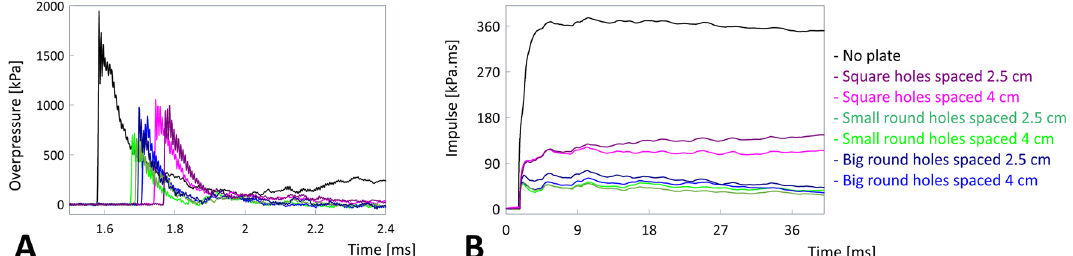
Fig. 12 Reflected overpressure ( A ) and impulse ( B ) measured on the wall positioned 50 mm behind two plates having either square or round holes, for two values of spacing. One reference test, which was performed without plates, is also shown